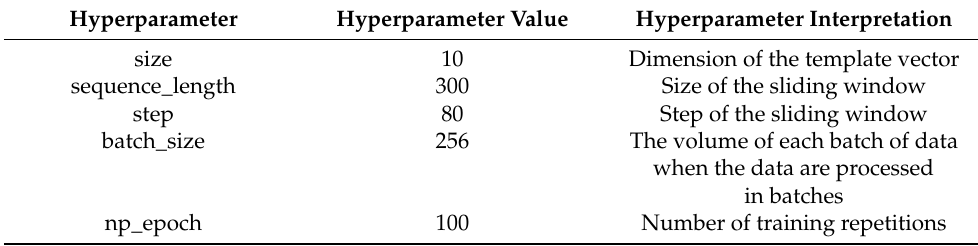
Table 4. Initial hyperparameter configuration table of the